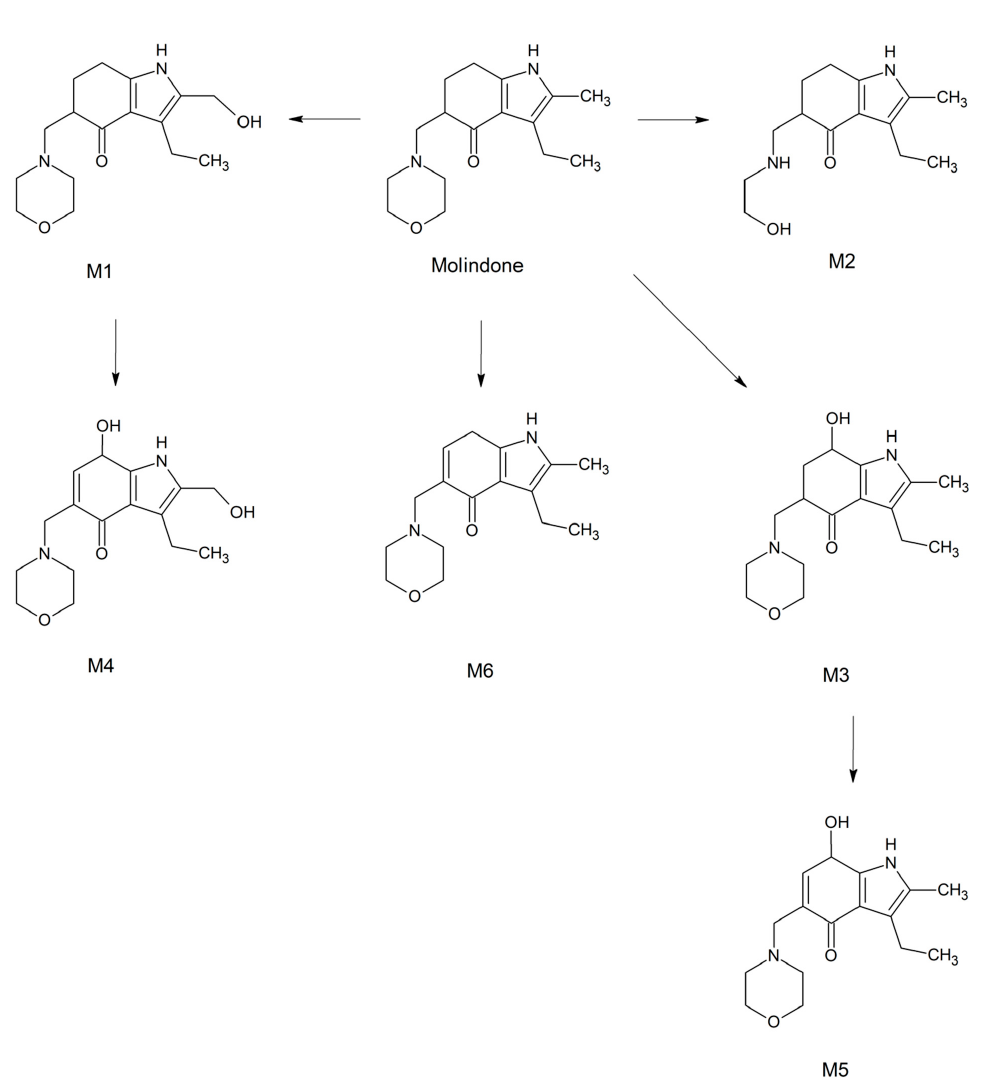
Figure 6. The proposed metabolic pathway of molindone.